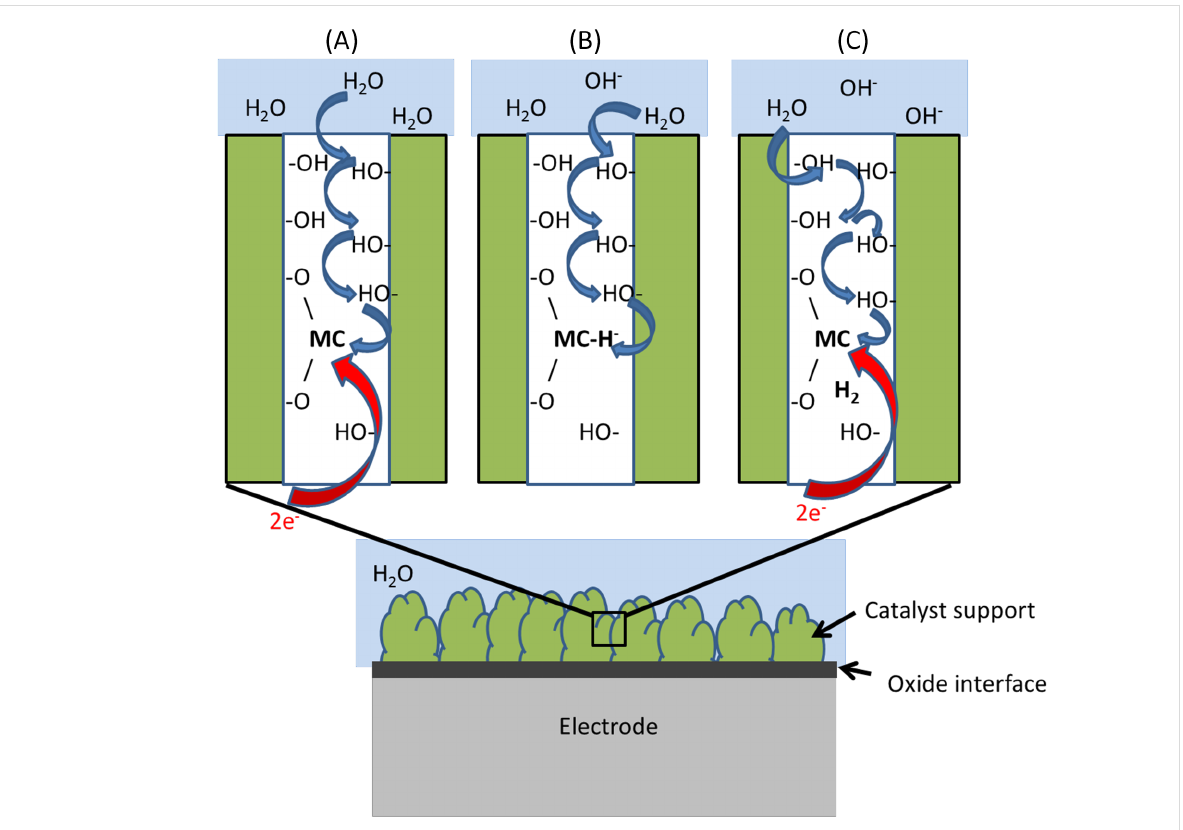
Figure 3: HER at electro-catalyst/electrode assembly. (A) Coalescence of proton and electrons to form the metal catalyst (MC) associated hydride, (B) Hydride-proton recombination to form H 2 at the interface. (C) The step between panel B and panel C comprises the HER following the hydride- proton recombination